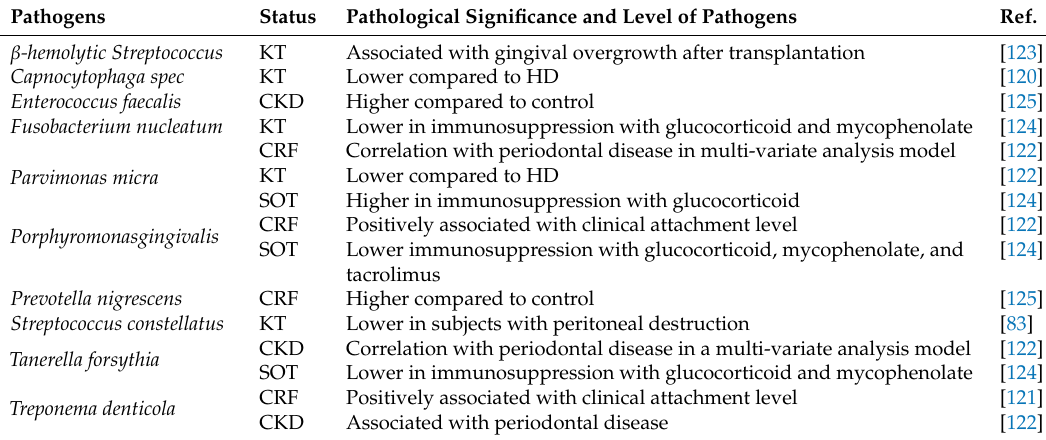
Table 1. Pathological significance and levels of pathogens according to kidney